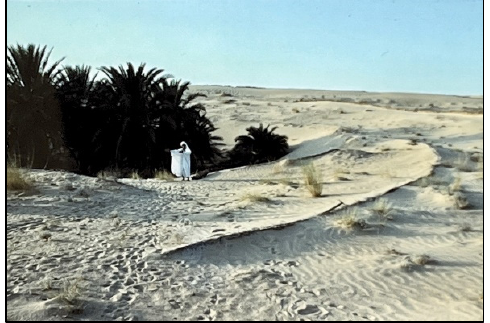
Figure 6. Ghouts, region of El ‐ Oued Souf, Algeria (photo: M. Sherzad).